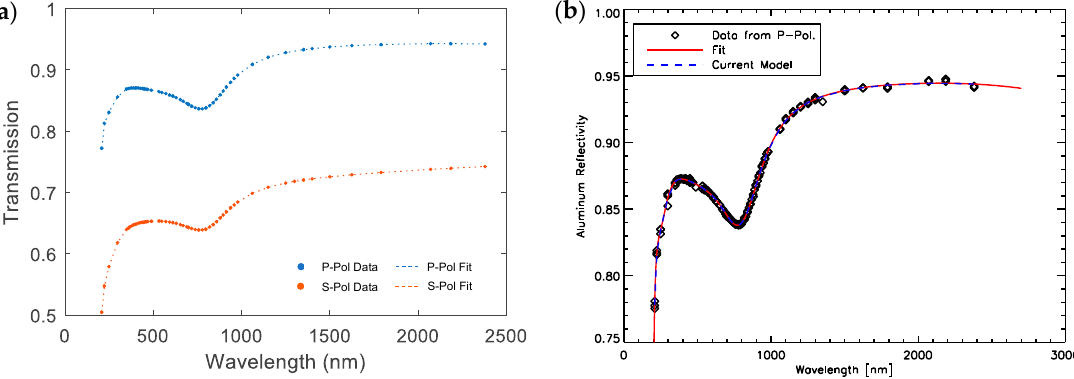
Figure 9. Measurement geometry for the determination of the prism transmission for the ESR detector. The ESR exit slit is located at y i = − 45 mm resulting in a refraction angle of 6.42 ◦ . The complete clear aperture of the prism is mapped for I / I o measurements and include a 9 × 9 grid of points (both laser polarizations). Average and standard deviation values are computed for the central area (elongated oval shown) to derive the transmission for the full solar image area on the prism. Note, the semicircular occultation (blue) in the lower portion of the figure is from the ball-in-cone mount for each of the prisms, which is clear of the solar view transmission region.